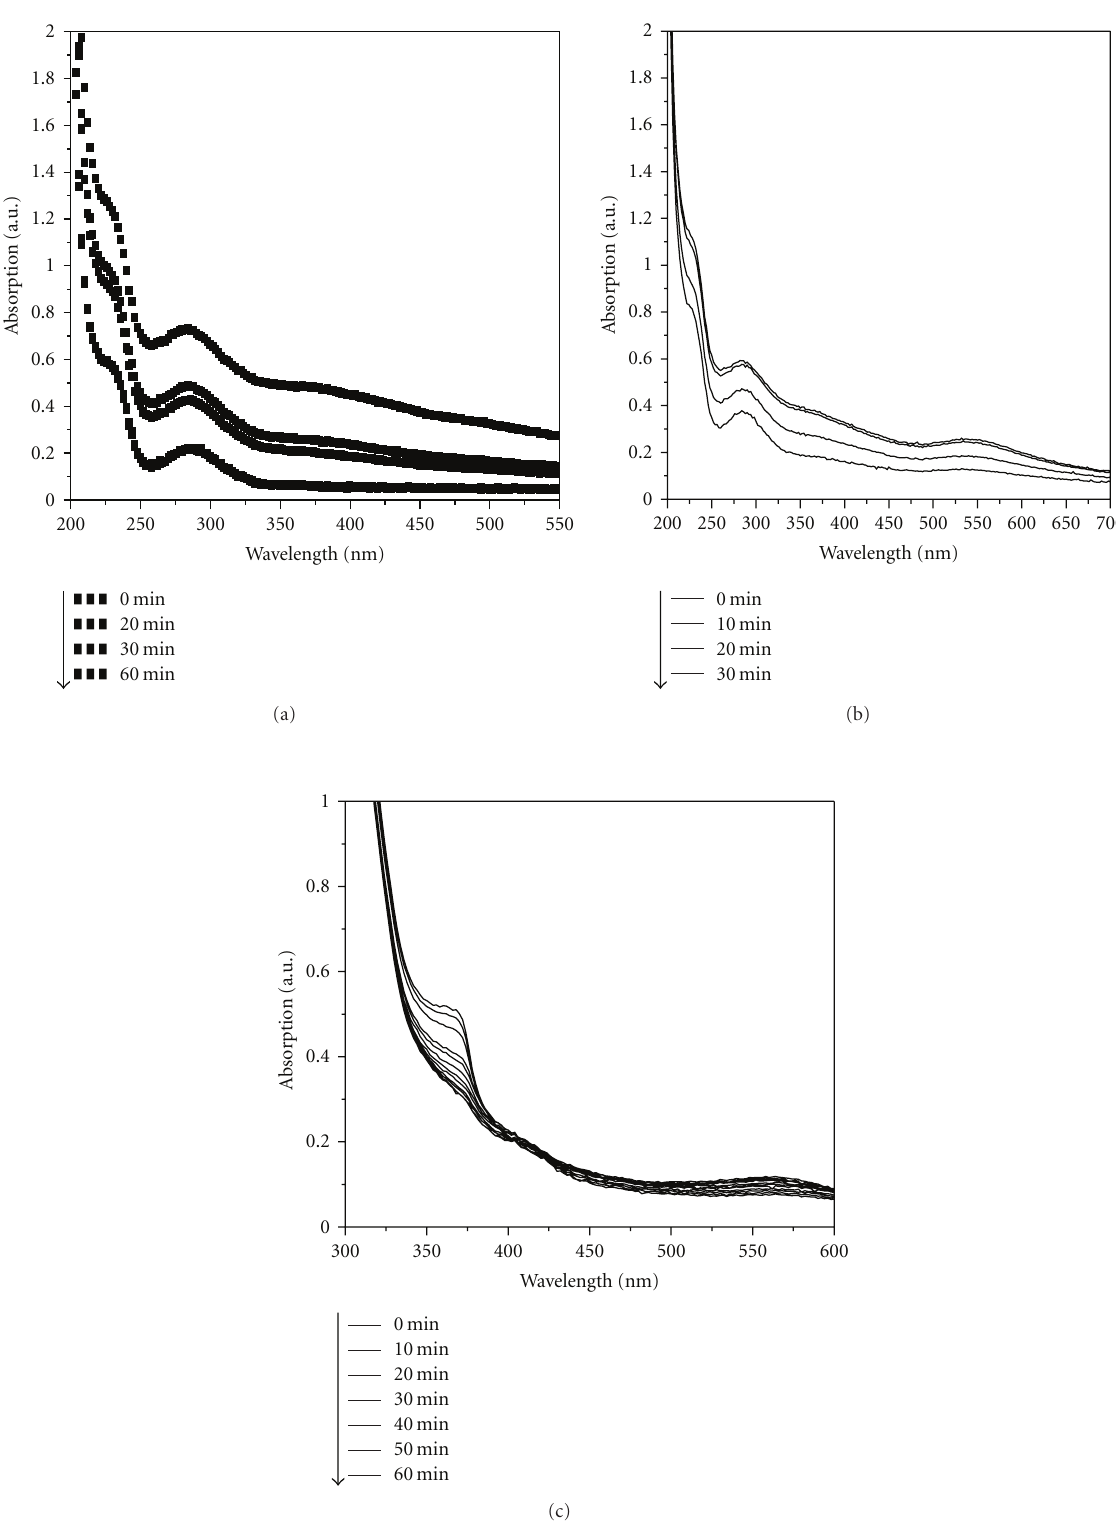
Figure 7: Time-dependent photodegradtion of cholridazon in UV lamp. (a) Addition of 10 − 4 Fe 3 O 4 . (b) Addition of 10 − 4 Fe 3 O 4 @Au. (c) Addition of